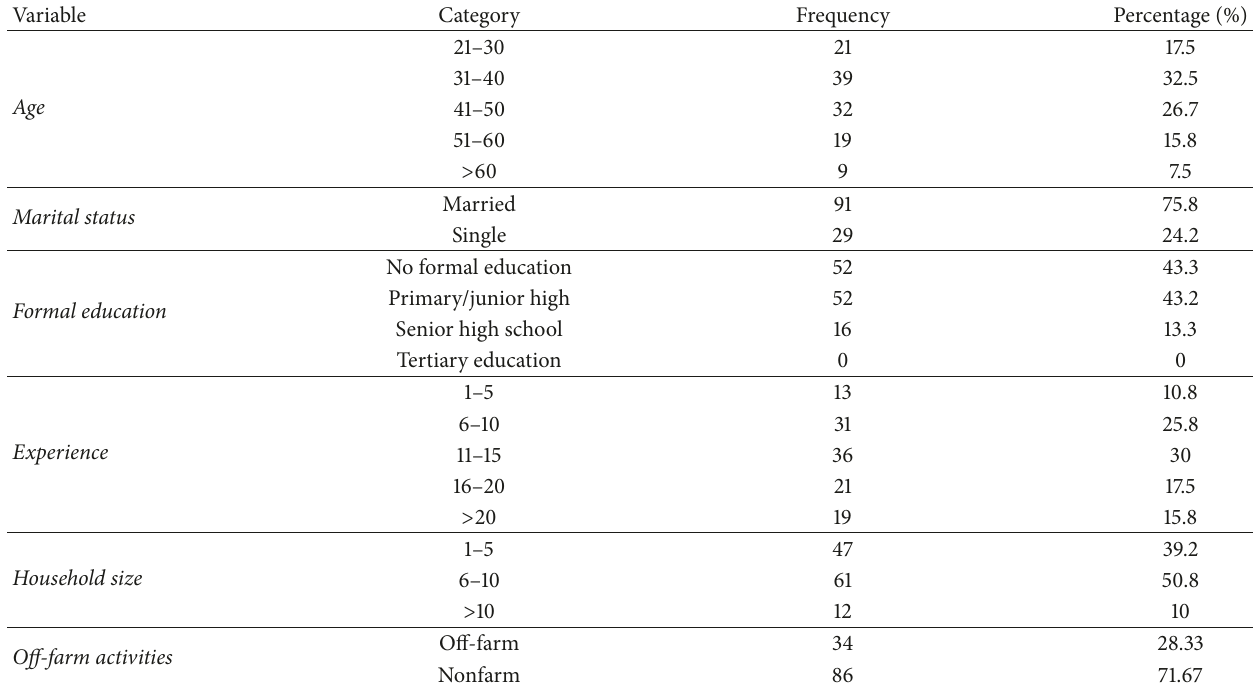
Table 1: Demographic characteristics of the artisanal fishers in Pru District.